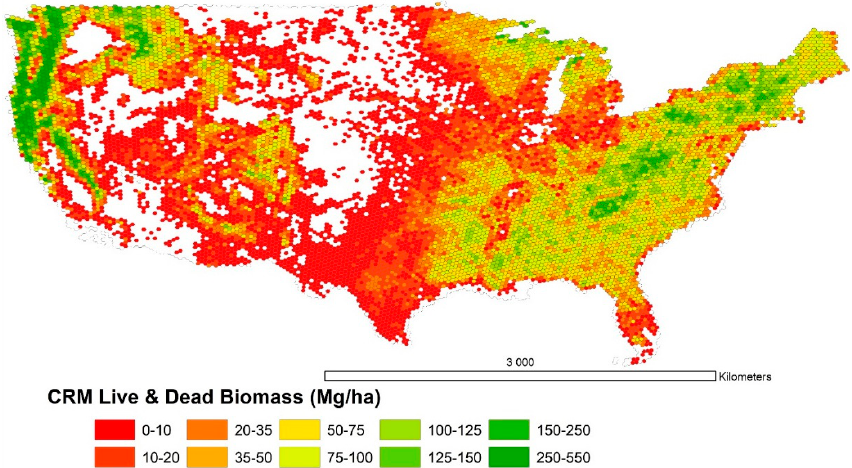
Remote Sens. 2020 , 12 , x FOR PEER REVIEW Figure 1. FIA hex-level estimates of CRM (Component Ratio Method) biomass. Figure 1. FIA hex-level estimates of CRM (Component Ratio Method) biomass.